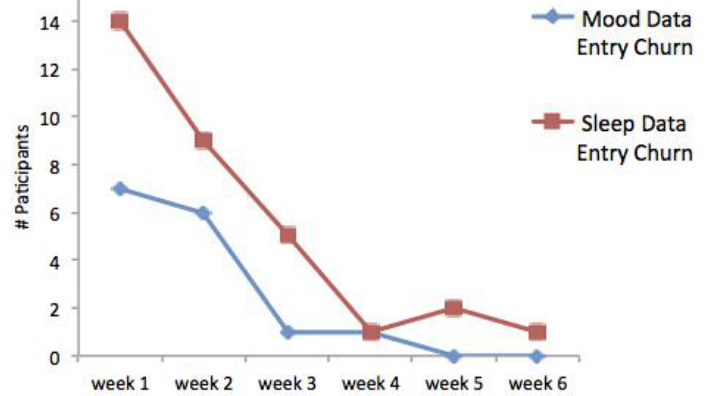
Figure 2. The number of participants who churned providing their mood or sleep data in mobileStd 2. This figure represents the problem of manual intervention requirements in a voluntary setting that participants will not receive reward while